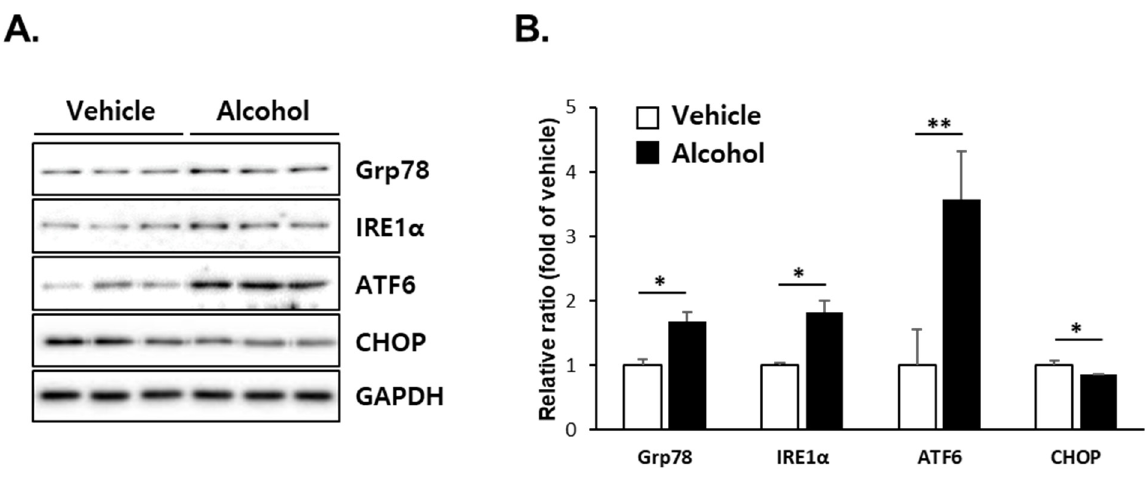
Figure 5. Alcohol binges increased hepatic ER stress in the liver of mice. Three consecutive doses of alcohol (5 g/kg, n = 5) or vehicle ( n = 5) were administered orally to mice at 12 h intervals. The mice were euthanized 12 h after the last alcohol treatment (designated as APAP 0 h). ( A ) Immunoblot analysis showing the protein levels of glucose-regulated protein (Grp78), inositol-requiring enzyme 1 α (IRE1 α ), activating transcription factor 6 (ATF6) and c/EBP homology protein (CHOP) in mice liver tissues at APAP 0 h. GAPDH was used as the loading control. ( B ) The expression levels of proteins were normalized to that of GAPDH. The results are expressed as the mean ± SD. *, ** Significantly different from the vehicle group (Student’s t test, p < 0.05, p < 0.01 and p < 0.001, respectively).